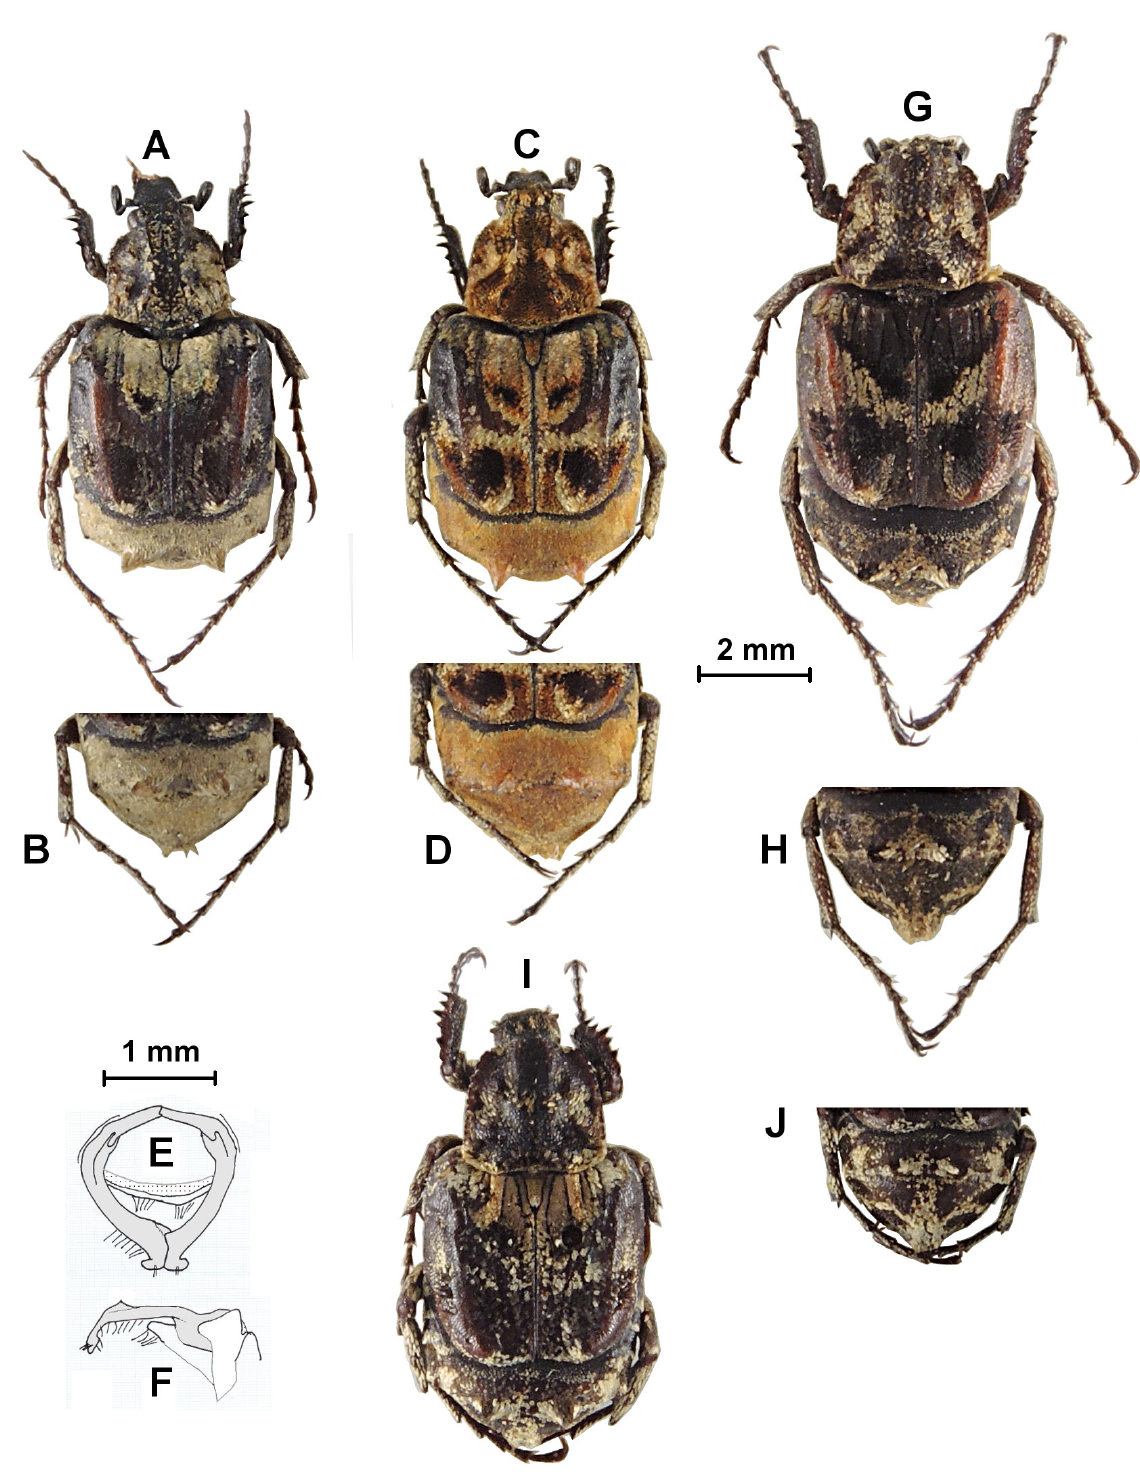
Fig. 9. Hybovalgus thibetanus (Nonfried, 1891). A–B . ♂ from Sichuan (ERC). A . Habitus, dorsal view. B . Propygidium and pygidium. C–D . ♂ from Yunnan (ERC). C . Habitus, dorsal view. D . Propygidium and pygidium. E–F . LT, ♂ (MNHUB). E . Aedeagus, dorsal view. F . Aedeagus, lateral view (grey: parameres; white: phallobase). G–H . ♀ from Sichuan (ERC). G . Habitus dorsal view. H . Propygidium and pygidium. I–J . ♀ from Shaanxi (ERC). I . Habitus, dorsal view. J . Propygidium and